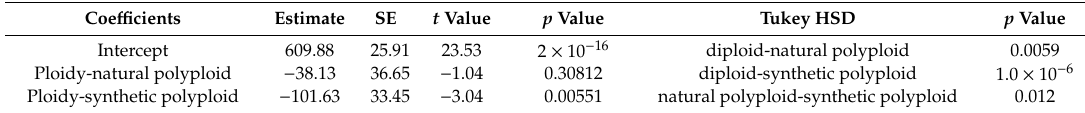
Table 2. Linear model results for cell number~ploidy.